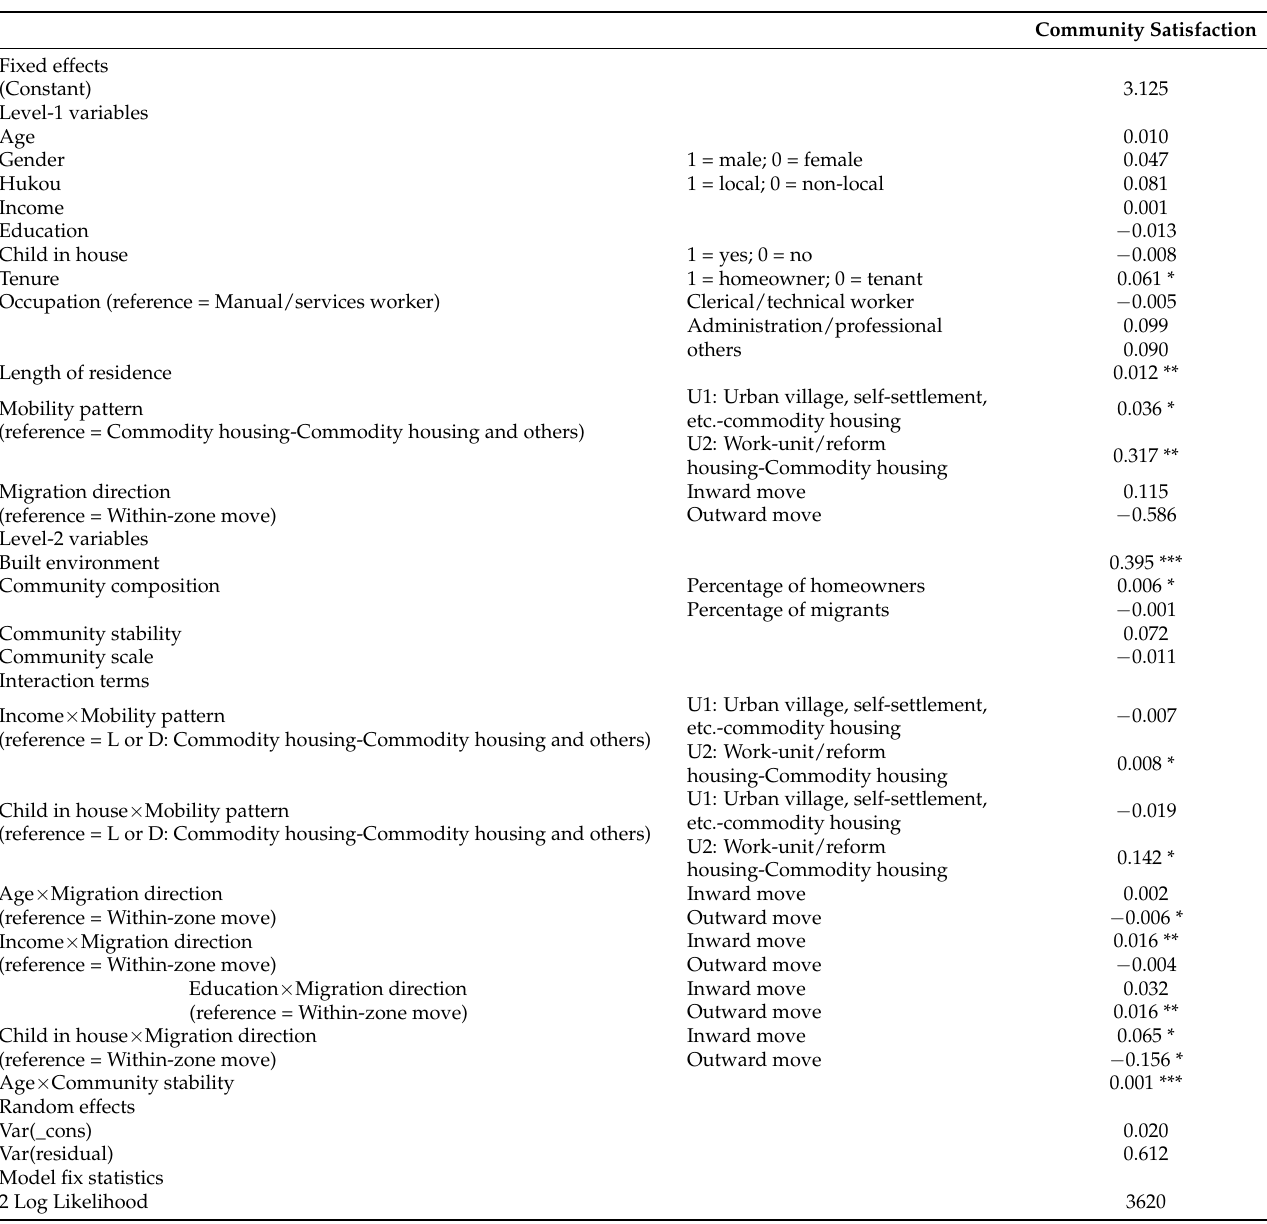
Table 3. Results of the mixed effect linear hierarchical regression of community